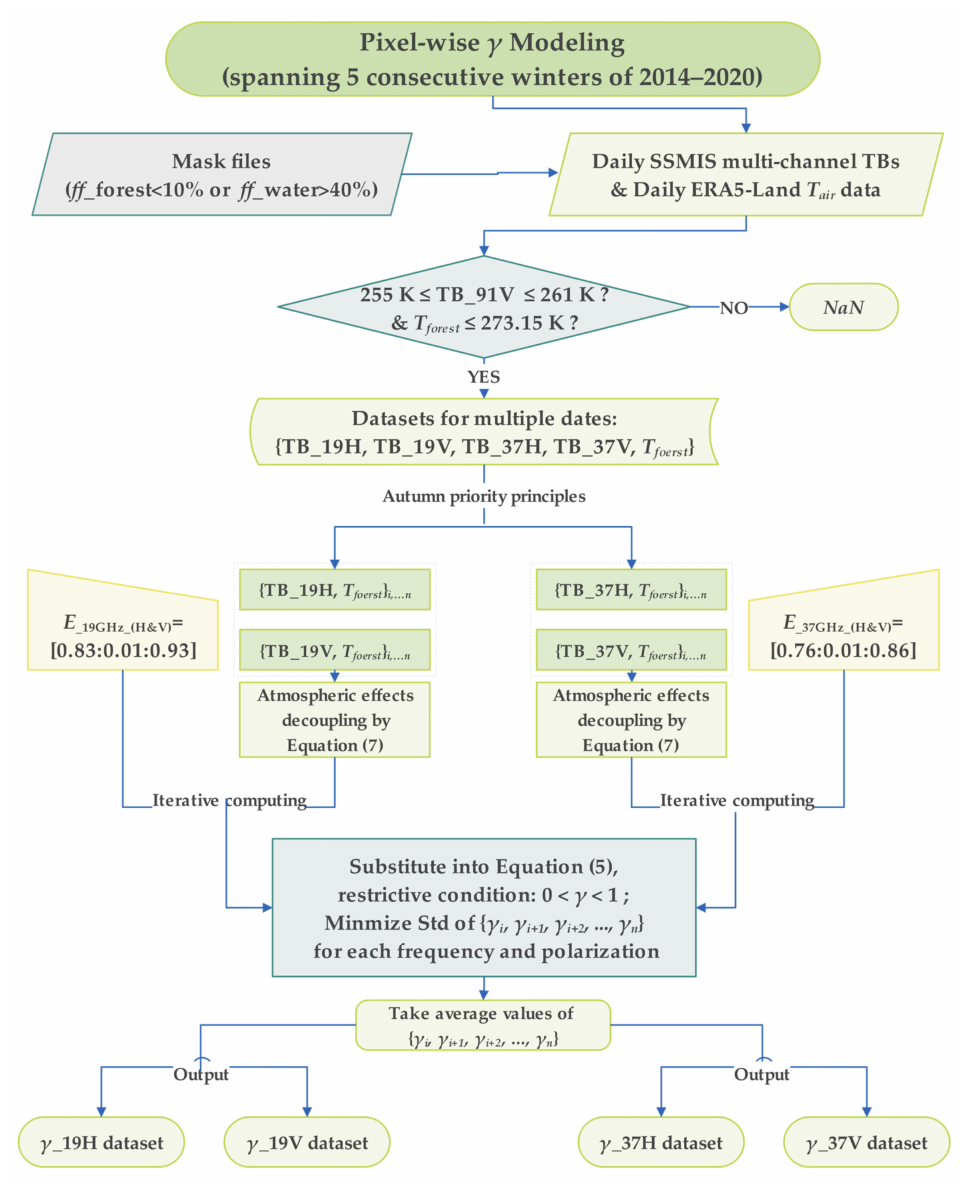
Figure 2. The framework of estimating the pixel-wise forest